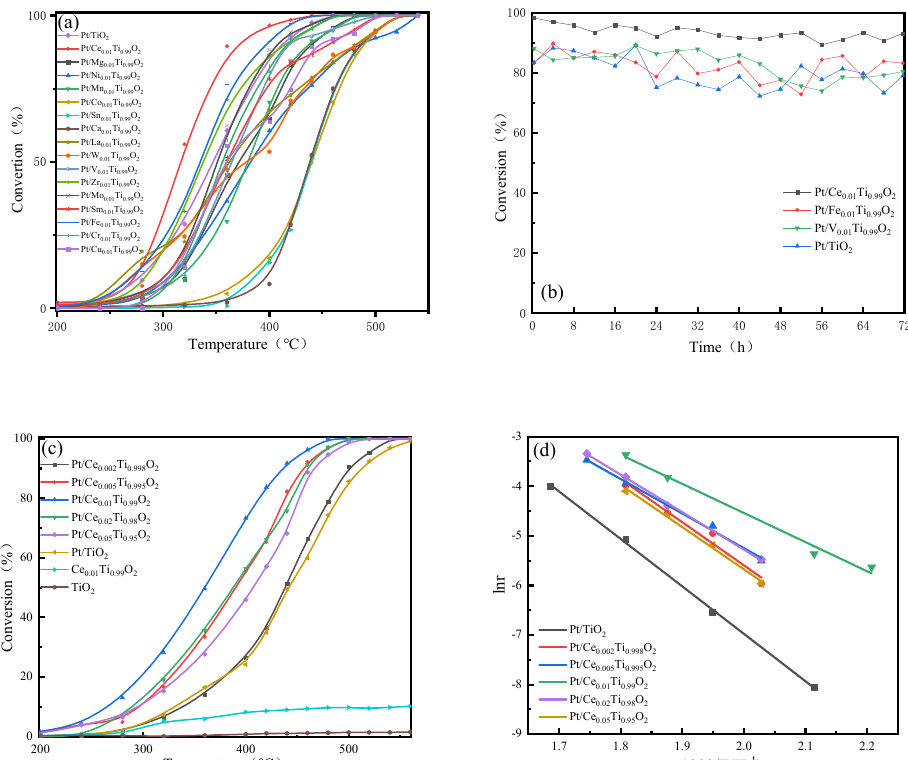
Figure 1. ( a ) Catalytic activity and ( b ) durability at 420 °C of part of M-Pt/TiO 2 catalysts. Reaction conditions: [C 2 H 6 ] = 1000 ppm, [O 2 ] = 4 vol%, [H 2 O] = 5%, [SO 2 ] = 100 ppm, balance N 2 , total flow rate = 200 mL/min, and GHSV = 60,000 h − 1 . ( c ) Catalytic activity of Pt/Ce x Ti 1 − x O 2 catalysts. Reaction conditions: [C 2 H 6 ] = 1000 ppm, [O 2 ] = 4 vol%, balance N 2 , total flow rate = 200 mL/min, and GHSV = 60,000 h − 1 . ( d ) Arrhenius plots of Pt/Ce x Ti 1 − x O 2 catalysts. Table 1. Catalytic activity and Ea values of Pt/Ce x Ti 1 − x O 2 (x = 0, 0.002, 0.005, 0.01, 0.02, and 0.05) catalysts.